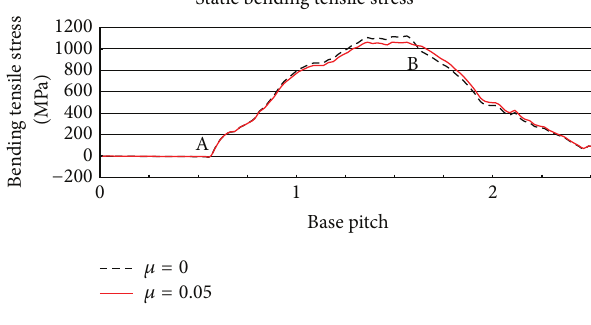
Figure 5: Static bending tensile stress